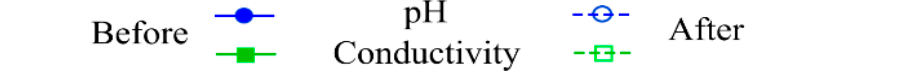
Figure 9. The impacts of disinfectants on stormwater pollution indicators before and after filtration.